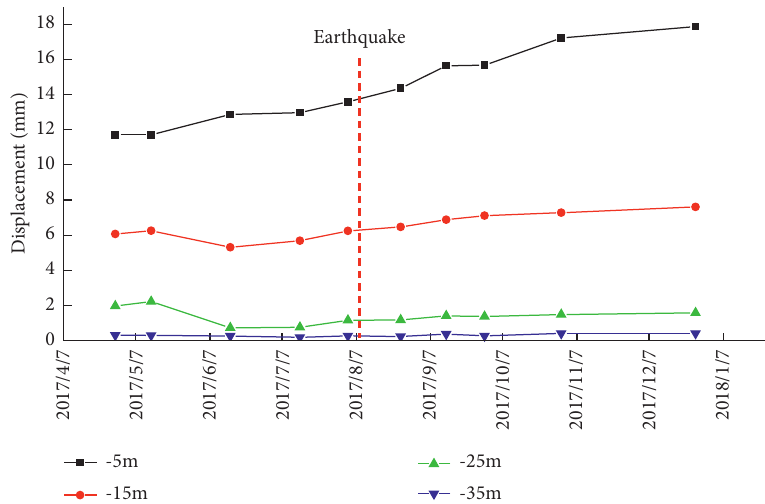
Figure 8: Displacement curve of 29# antislide pile at same depths during the